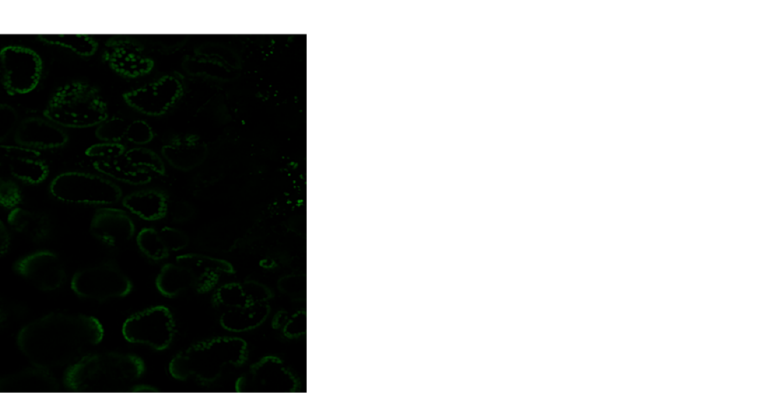
Figure 4. Relative transcript levels of several important genes involved in host defense signaling pathways were assessed by quantitative RT-PCR at 7 days post-inoculation. The expression of WRKY70 and PDF1.2 showed significantly higher expressions in Lm solely inoculated cotyledons. PR1 , WRKY33 , RbohD , APX6 , and CHI showed significantly higher expression in cotyledons inocu- lated with only Lb. ( a ) Relative gene expression of WRKY70 and PR1 ; ( b ) Relative gene expression of WRKY33 and PDF1.2 ; ( c ) Relative gene expression of RbohD and APX6 ; ( d ) Relative gene expres- sion of CHI ; in Westar cotyledons inoculated with only DsRed-tagged L. biglobosa (Lb), with only GFP-tagged L. maculans (Lm) and co-inoculated with both isolates (Lm + Lb). Different letters refer to significant differences (p ≤ 0.05). Figure 5. Expression profile of RbohD in Westar cotyledons infected with LmGFP, LbDsRed as sole and combined inocula. RbohD expression was upregulated at an exponential rate from 3- to 7- dpi. The observations were taken at 0-, 6-, 12- hpi and 1-, 3-, 7- dpi.